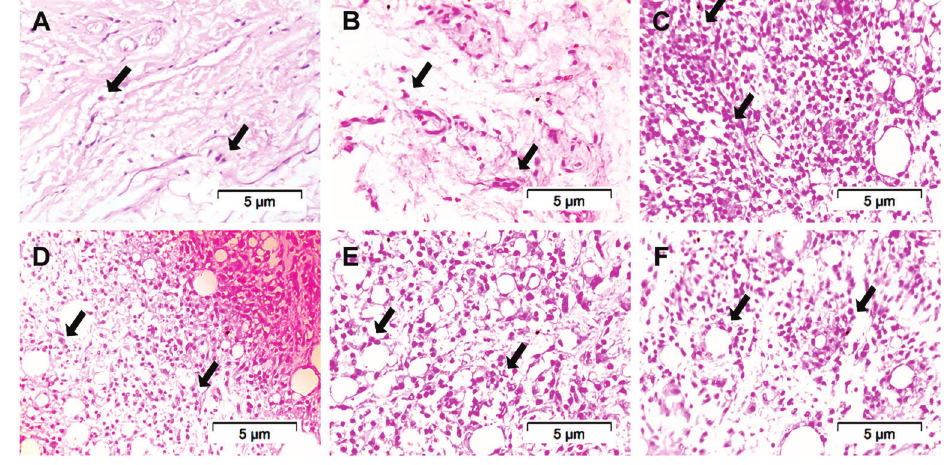
Figure 9. Histological analysis of the rat right hind footpad 11 days after injection of Freund ’ s complete adjuvant (CFA) (40 (cid:1) ) showing the number of immune cells (arrows). A , Contralateral paw B : Sham; C , vehicle; D , terpinolene monoterpene (TPL) (25 mg/kg, po ); E , diclofenac (DCF) (5 mg/kg, po ), and F , TPL (3.125 mg/kg, po ) + DCF (1.25 mg/kg, po